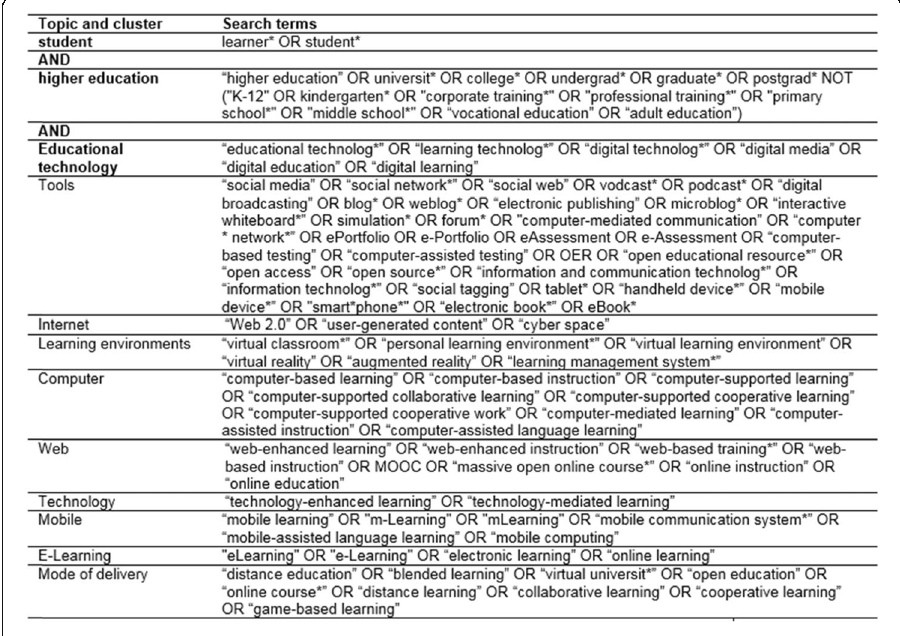
Fig. 1 Final search terms used in the systematic